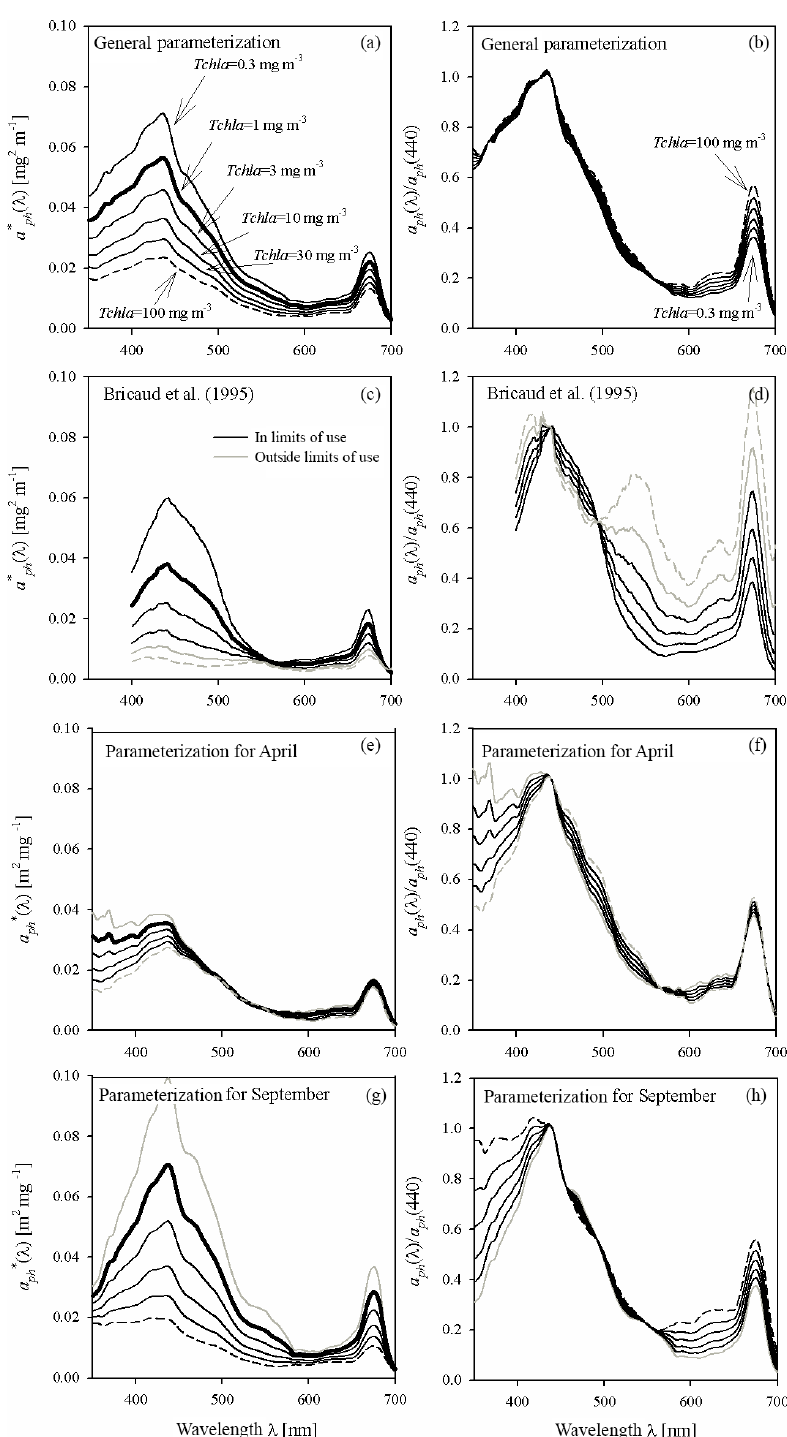
(λ) (left-hand column) and spectra of a ph ph